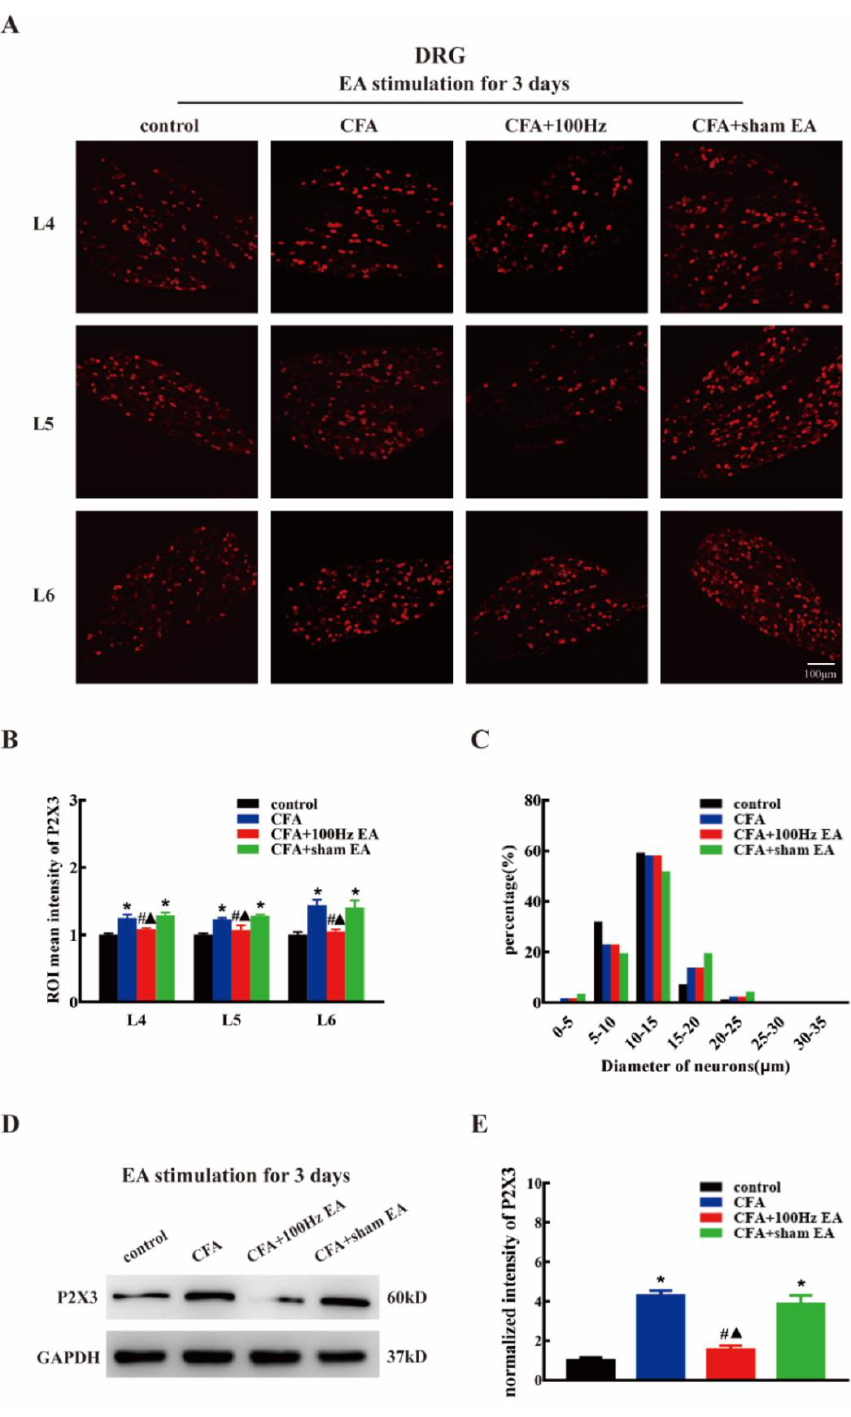
Figure 2. The 100 Hz EA stimulation for 3 days repressed the up-regulation of P2X3 in the L4-6 dorsal root ganglions (DRG) of inflamed rats. ( A ) Representative images of L4-6 DRG immunofluorescence staining from the control, CFA, CFA+100 Hz EA and CFA + sham EA groups. Scale bars = 100 μm. ( B ) Mean intensity analysis of P2X3-ir in L4-6 DRG in each group. Data are presented as the mean ± SEM, n = 3. ( C ) Size distribution of P2X3 in L4-6 DRG in different groups. ( D ) Representative western blotting images of L4-6 DRG in each group. E. Relative protein level of P2X3 in rat L4-6 DRG from different groups. Data are presented as the mean ± SEM, n = 6. * P < 0.05, compared with the control group; # P < 0.05, compared with the CFA group; ▲ P < 0.05, compared with the CFA + sham EA group.